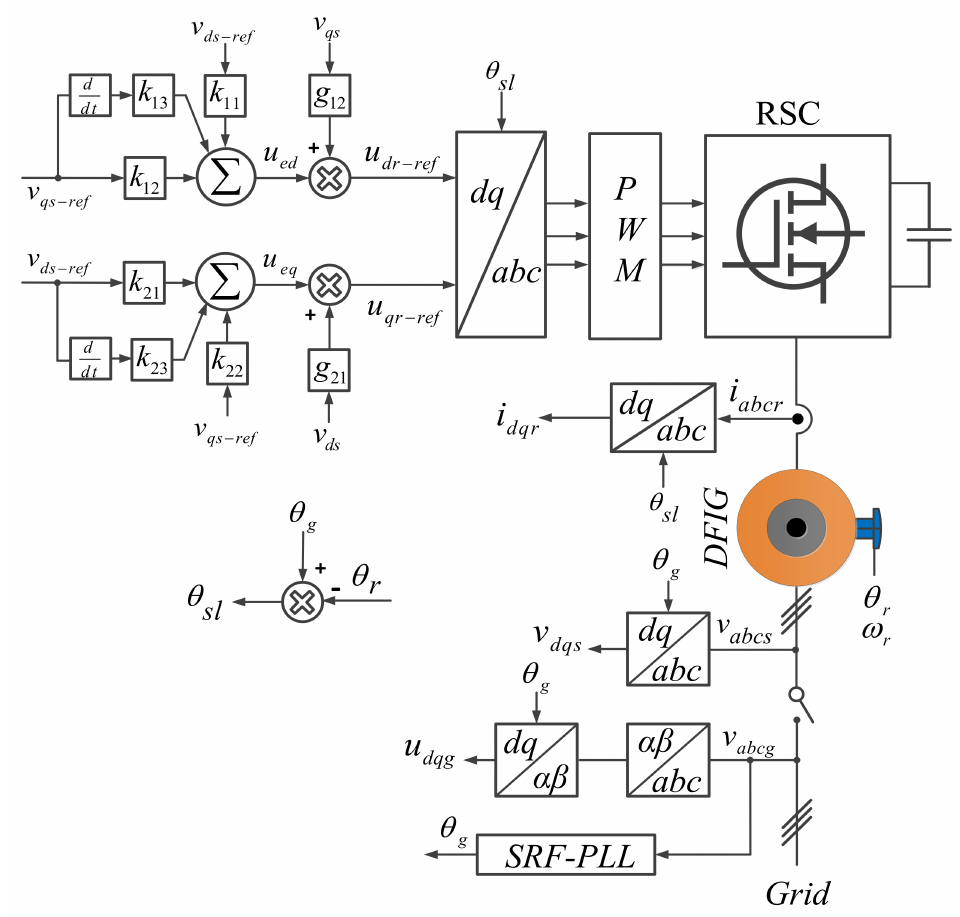
Figure 2. Proposed LMI-based state feedback control